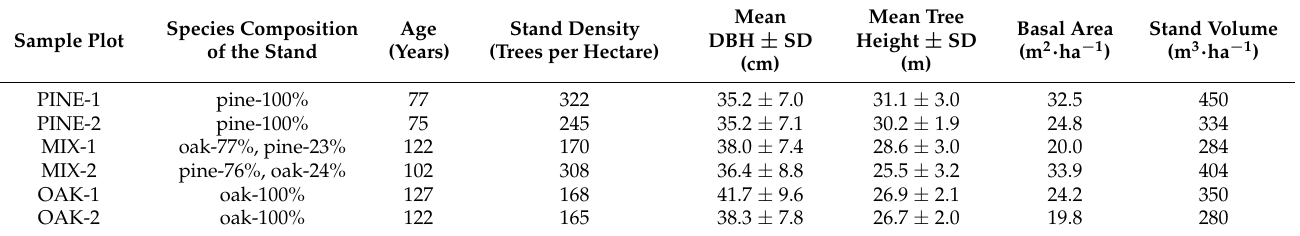
Table 1. Main characteristics of coniferous (PINE-1, PINE-2), mixed (MIX-1, MIX-2), and deciduous (OAK-1, OAK-2) sampled